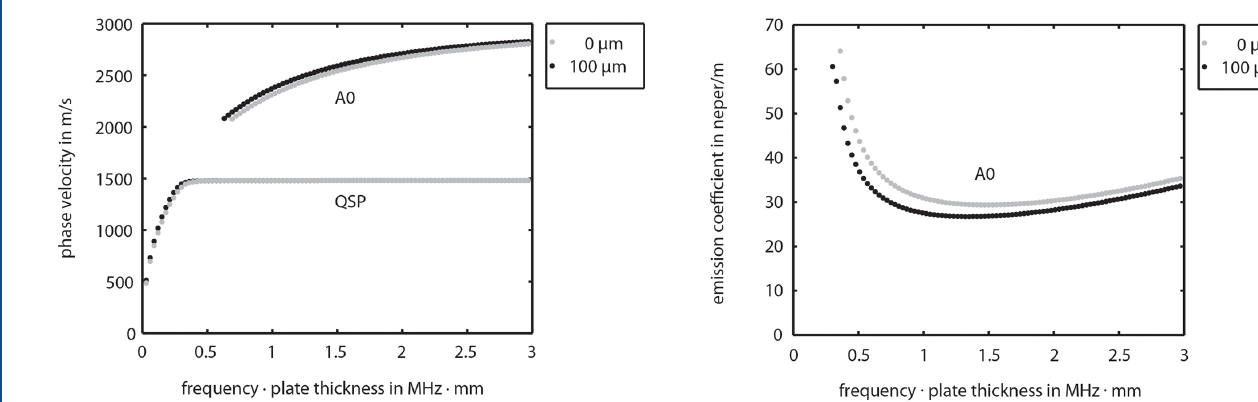
Figure 14. Emission diagram of a steel plate ( v l = 5707ms − 1 , v s = 3155ms − 1 , ρ = 7850kgm − 3 , d = 1mm) with and without a nickel coating ( v l = 5793ms − 1 , v s = 3202ms − 1 , ρ = 8000kgm − 3 ) of 100 µ m thickness in contact with a water half-space ( v l = 1480ms − 1 , ρ = 1000kgm − 3